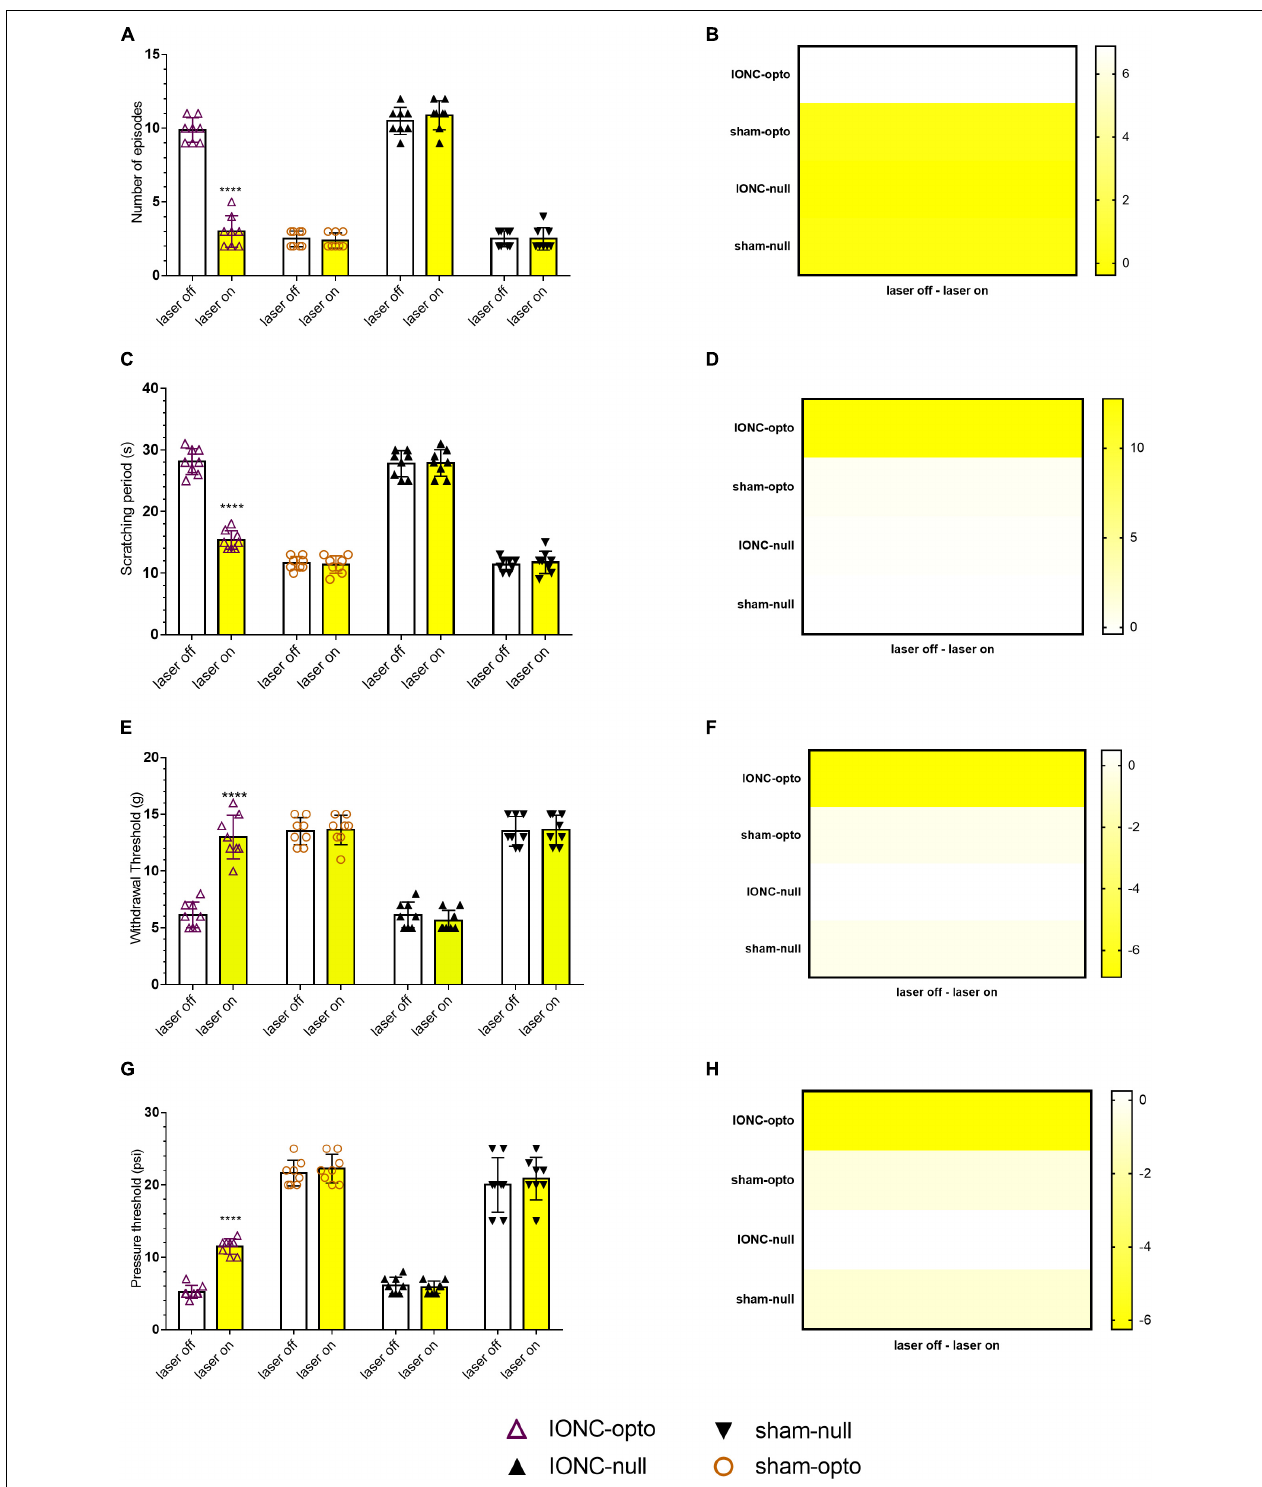
FIGURE 4 | Hypersensitivity induced by IONC improved with TG neuron optogenetic inhibition. (A) Decreased number of episodes noted in response to yellow laser stimulation in the face grooming test. (B) Heatmap for face grooming test. (C,D) Cold acetone test response in TG neurons with yellow laser stimulation. (E,F) In the IONC opto groups, yellow laser stimulation increased the air pressure threshold in the air puff test. (G,H) In the von Frey filament test, an improved mechanical threshold was revealed in response to TG neuron inactivation with a yellow laser. Data are presented as the mean ± SD. **** P < 0.0001 compared to other group (two-way